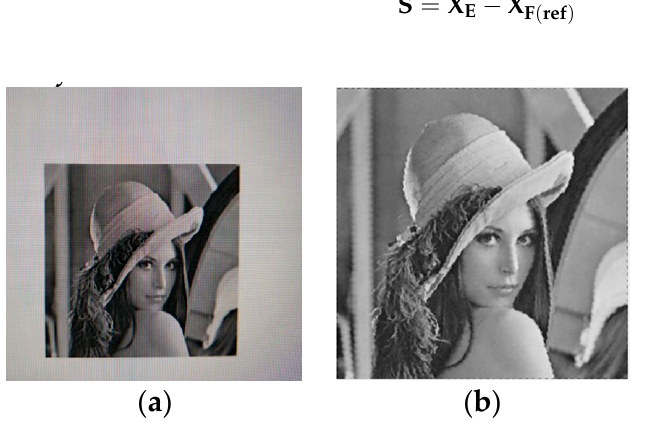
Figure 5. ( a ) The captured image, and ( b ) reconstructed image